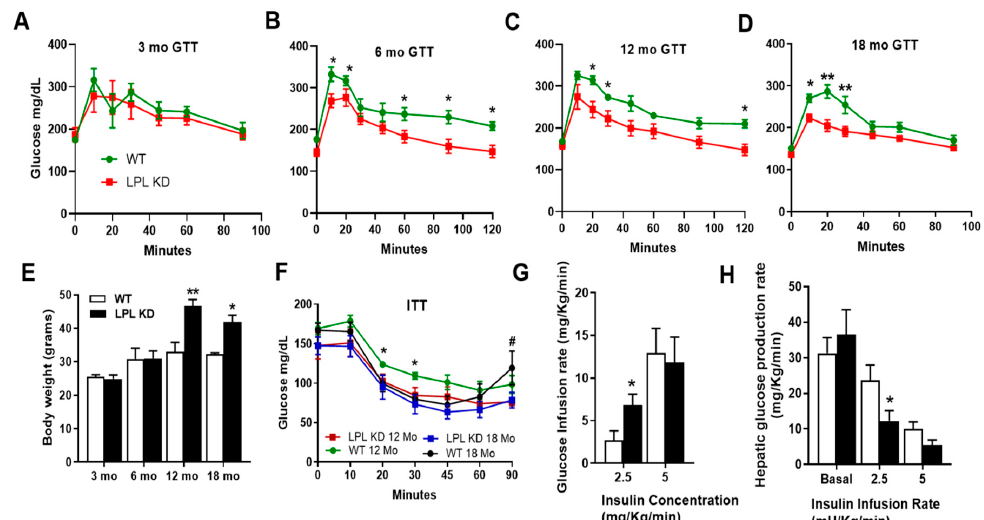
Figure 1. Neuronal lipoprotein lipase (LPL) deficiency improves glucose tolerance with aging. ( A – D ) Measurements of glucose tolerance in (NEXCreLPL flox ) LPL KD versus WT (LPL flox ) mice at 3 ( A ), 6 ( B ), 12 ( C ), and 18 ( D ) months. ( E ) The body weights of LPL KD (black) and WT (white) mice before terminal experiments at each age point. ( F ) Intraperitoneal (IP) insulin tolerance tests (ITT) in 12 and 18 months in WT mice. ( G ) Steady state whole body glucose infusion rate in LPL KD (black) mice compared to WT (white). ( H ) Endogenous glucose production (EGP) rate in LPL KD mice compared to WT controls. (Where # = p < 0.1, * = p < 0.05, and ** = p <0.01 vs. aged-matched WT controls).